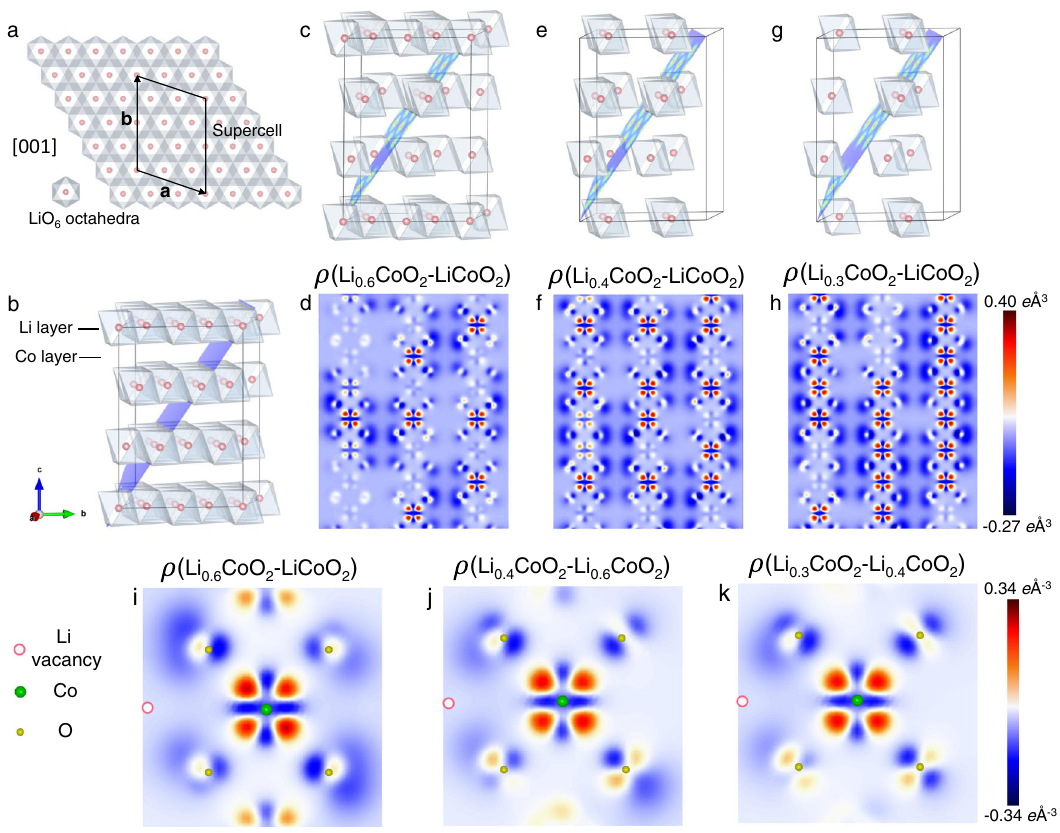
Fig. 4| Theoreticaldifferenceelectron-densitymaps.a Constructed supercellof the Li layer containing ten Li atoms along the [001] direction. b The c -axis of the supercell is the same as that of LiCoO 2 and consists of three Li layers, three Co layers, and six O layers, with each layer containing ten atoms. Therefore, the supercellcontains30Liatoms,30Coatoms,and60Oatoms. c , e , g Con fi gurations with the lowest electrostatic energy of Li 18 Co 30 O 60 , Li 12 Co 30 O 60 , and Li 9 Co 30 O 60 , respectively. To clearly illustrate the arrangement of the Li vacancies, only the Li layersaredisplayedinthestructuremodels. d , f , h Correspondingelectron-density